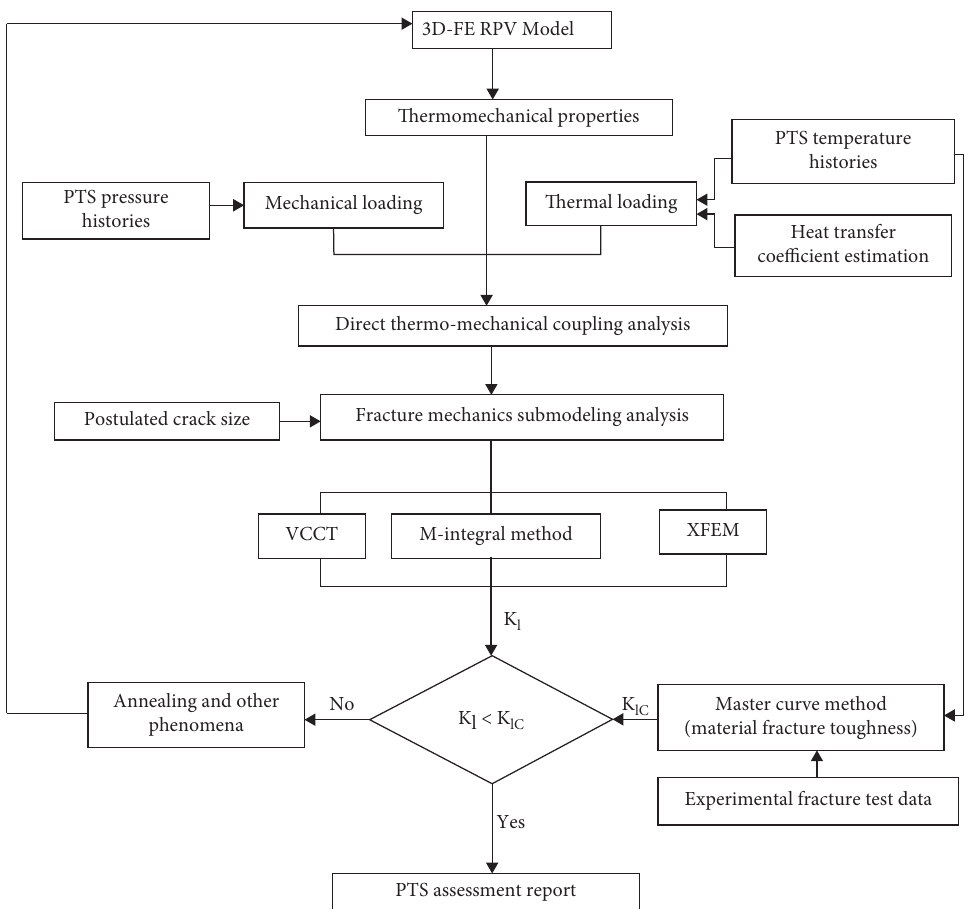
Figure 3: Flow diagram of the multistep analysis of RPV under PTS transient